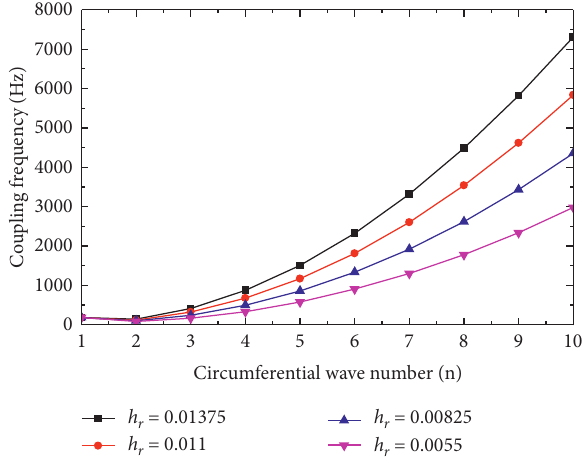
Figure 5: Coupling frequency curves of different rib